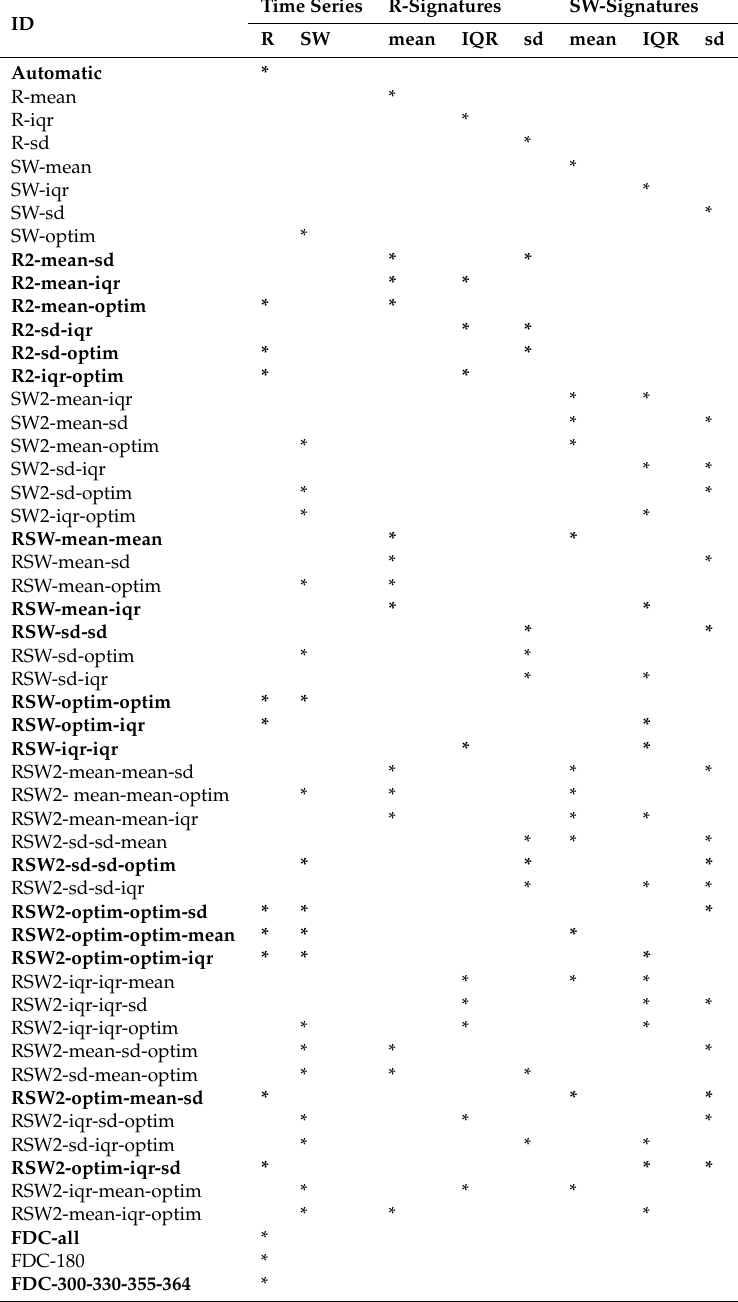
Table A1. Optimal OFs are denoted in bold. The time series column contains time series as runoff (R) and soil moisture (SW). The column’s hydrological signature of (R) and (SW) is combined with statistical indicators as mean, IQR, sd and selected settings